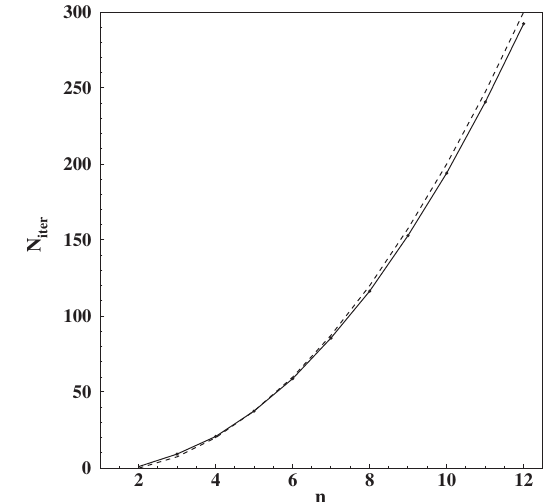
FIG. 1. Solid line: Number of iterations required to bring a 2 n (cid:2) 2 n symplex (Hamiltonian matrix) to Hamiltonian form. Dashed line: Approximation by 5 n ð n (cid:1) 2 Þ nondiagonal 2 (cid:2) 2 blocks is n